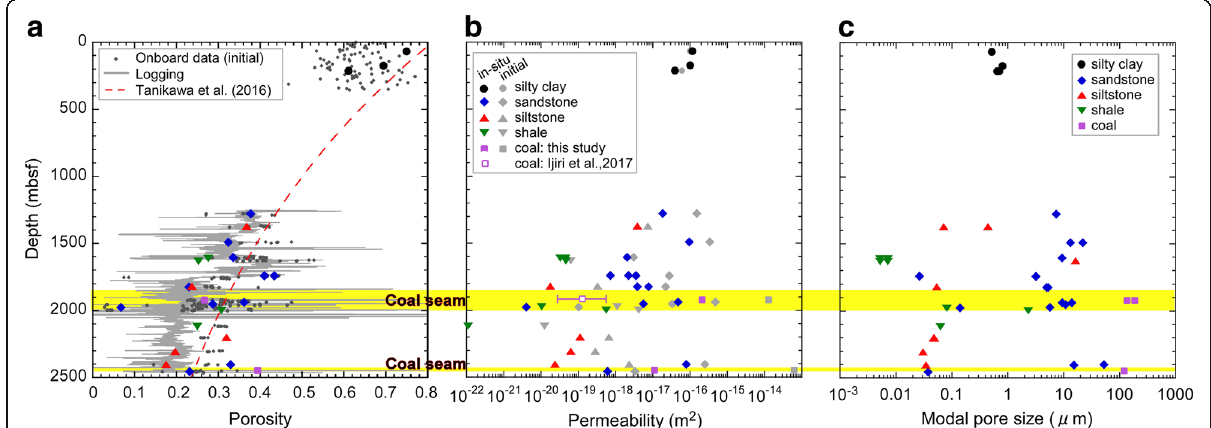
Fig. 5 Depth profiles for a in-situ porosity, b in-situ permeability, and c modal pore size distribution. The legend shows the lithology of the core samples. Logging data and porosity data are modified from Inagaki et al. (2012). In-situ porosity and in-situ permeability values were estimated based on the relationship between porosity/permeability and effective pressure, as shown in Fig. 4. The initial permeability plotted in ( b ) is the measured value at low effective pressure (1 to 3 MPa). The modal pore size was obtained from MICPT measurements under unconfined